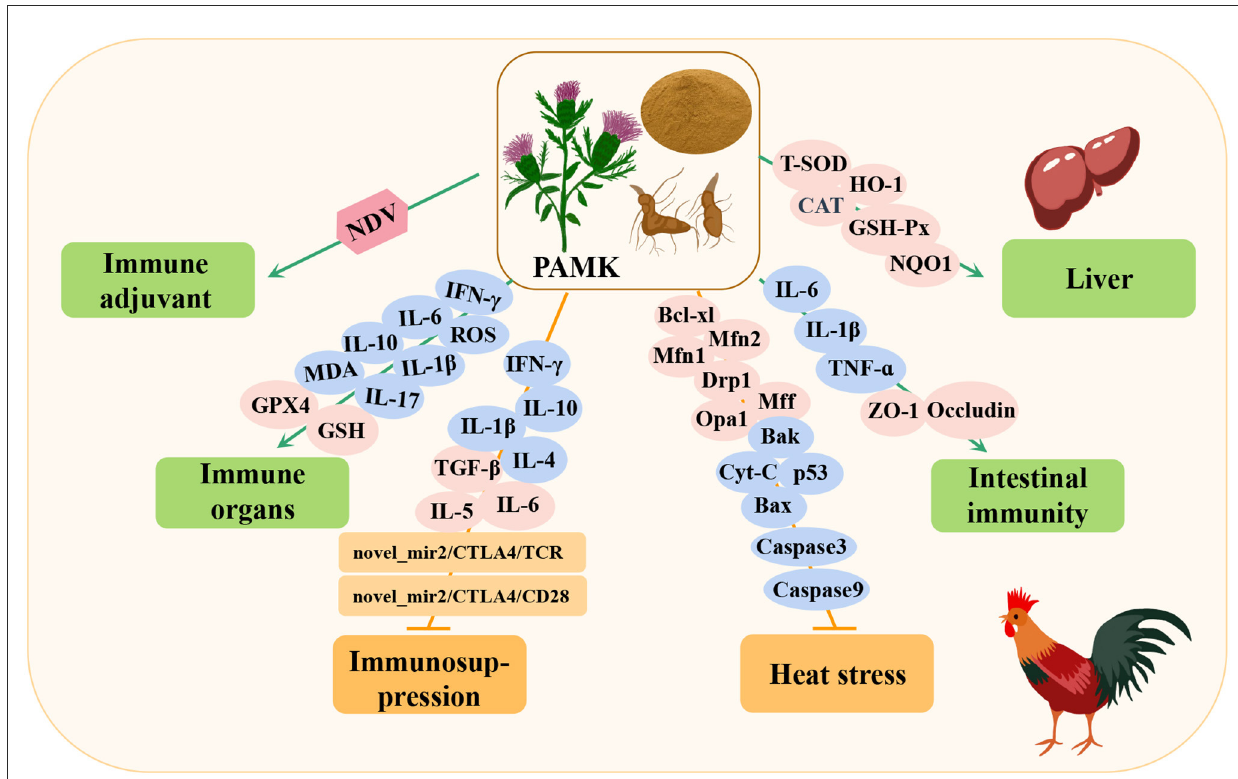
FIGURE1 Immunomodulation and protection of immune organs by Atractylodes macrocephala Koidz polysaccharide (PAMK) in poultry. NDV, newcastle disease virus; IFN- γ , interferon-gamma; IL-6, interleukin-6; IL-10, interleukin-10; MDA, malonaldehyde; ROS, reactive oxygen species; IL-1 β , interleukin 1 beta; IL-17, interleukin-17; GSH, glutathione; GPX4, glutathione peroxidase 4; IL-4, interleukin-4; TGF- β , transforming growth factor- β ; IL-5, interleukin-5; Bcl-xl, BCL2-like 1; Mfn1, mitofusin 1; Mfn2, mitofusin 2; Drp1, dynamin-related protein 1; Opa1, mitochondrial dynamin like GTPase; Mff, mitochondrial fission factor; Bak, BCL2 antagonist/killer 1; Bax, BCL2-associated x; Cyt-C, cytoplasmic cytochrome c; p53, tumor protein p53; TNF- α , tumor necrosis factor- α ; ZO-1, zonula occludes protein; CAT, catalase; HO-1, heme oxygenase 1; GSH-Px,